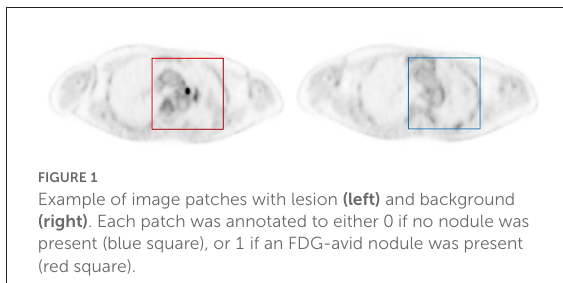
obtain 9 different predefined true count levels with 20 × 10 6